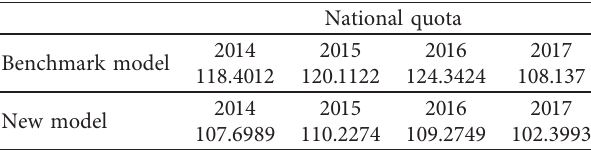
Table 10: National quota. Table 11: Parameters of the new